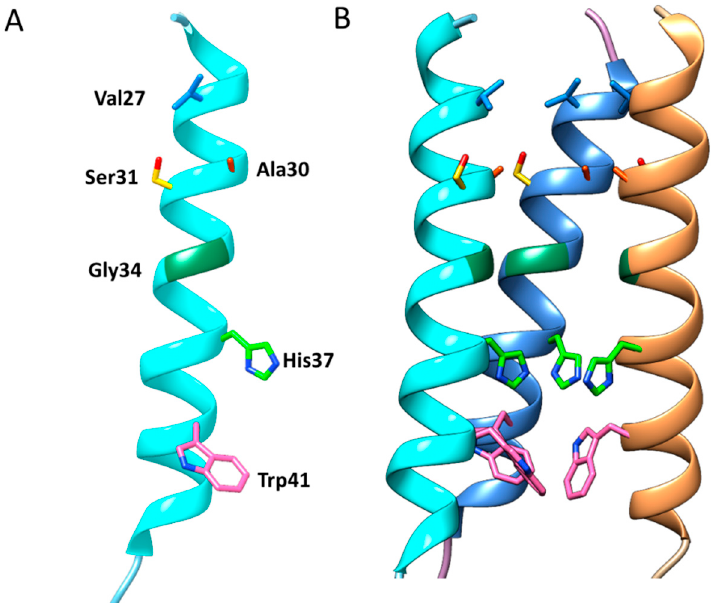
Figure 3. Three-dimensional structure of the influenza A M2 (AM2) ion channel. ( A ) A monomer of the AM2 protein transmembrane domain (TMD) displaying channel facing amino acid residues; ( B ) Organization of four TMDs, and the alignment of pore-lining residues. For clarity, three AM2 monomers are shown to expose the sidechains of the pore-lining residues. The NMR structure with PDB ID 2RLF was used (prepared by authors).